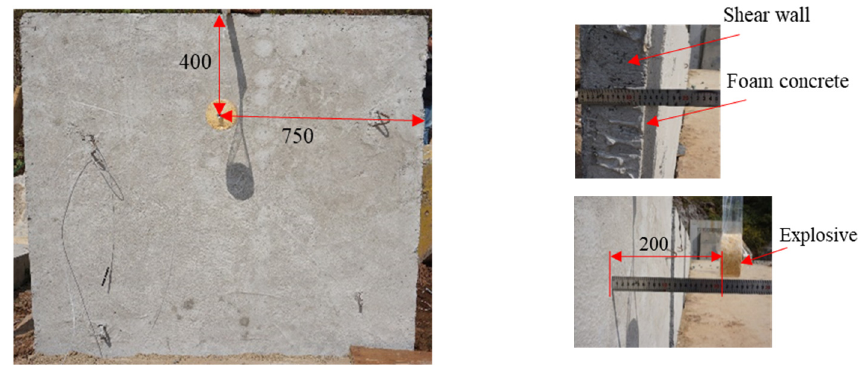
Figure 7. The layout of the blast experiments site (unit: mm).